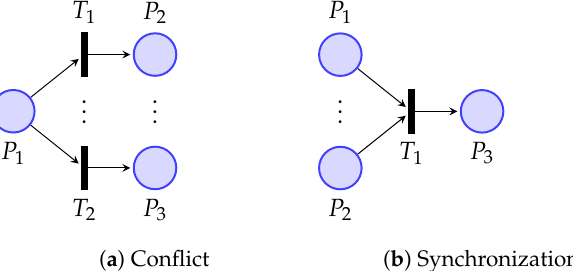
Figure 2. Elementary Petri Net structures in which the transitions must be actively controlled and always belong to the set of controlled transitions T C